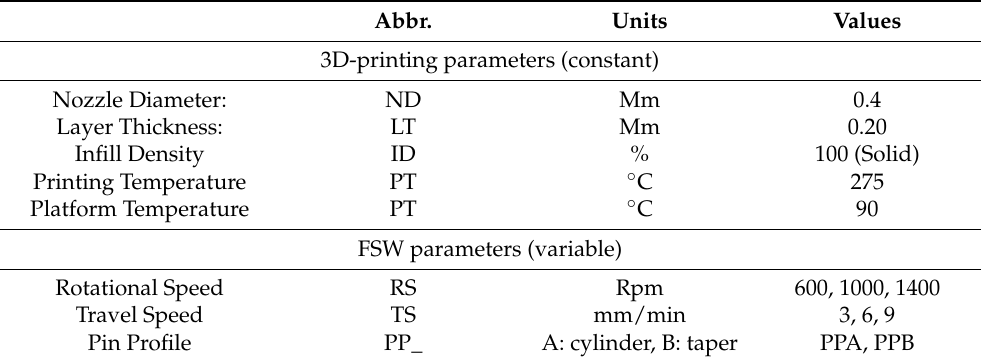
Table 1. MEX-FSW parameters.